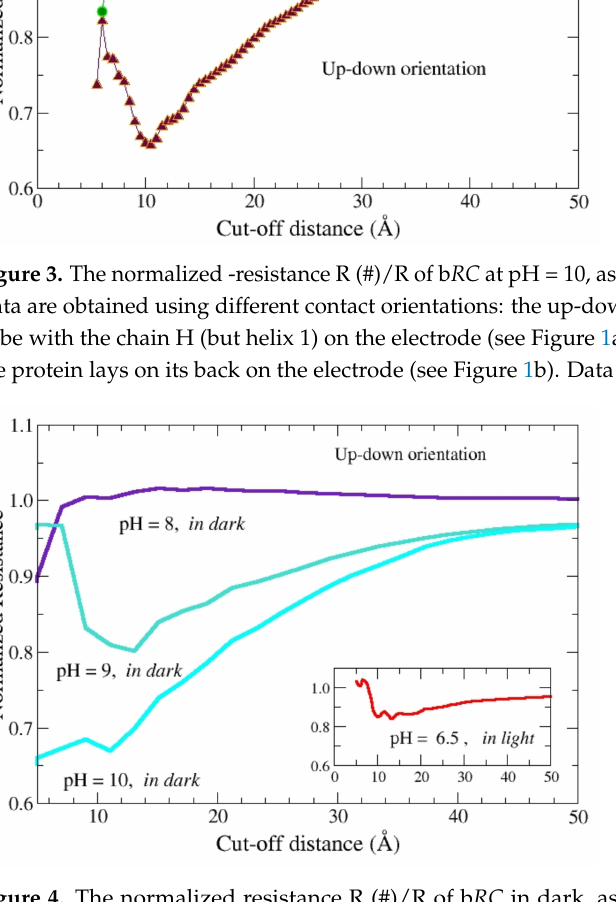
Figure 4. The normalized resistance R (#)/R of b RC in dark, as a function of the cut-off distance between neighborhood nodes, D, at different values of pH. Calculations refer to up-down orientation and three different pH values. The inset reports the normalized resistance R (#)/R in light for pH =